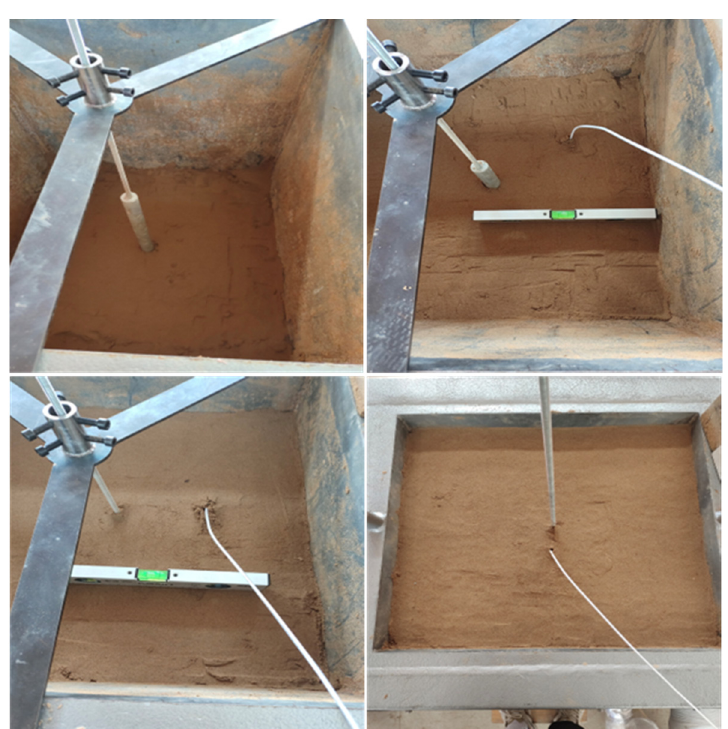
Figure 6. Filling